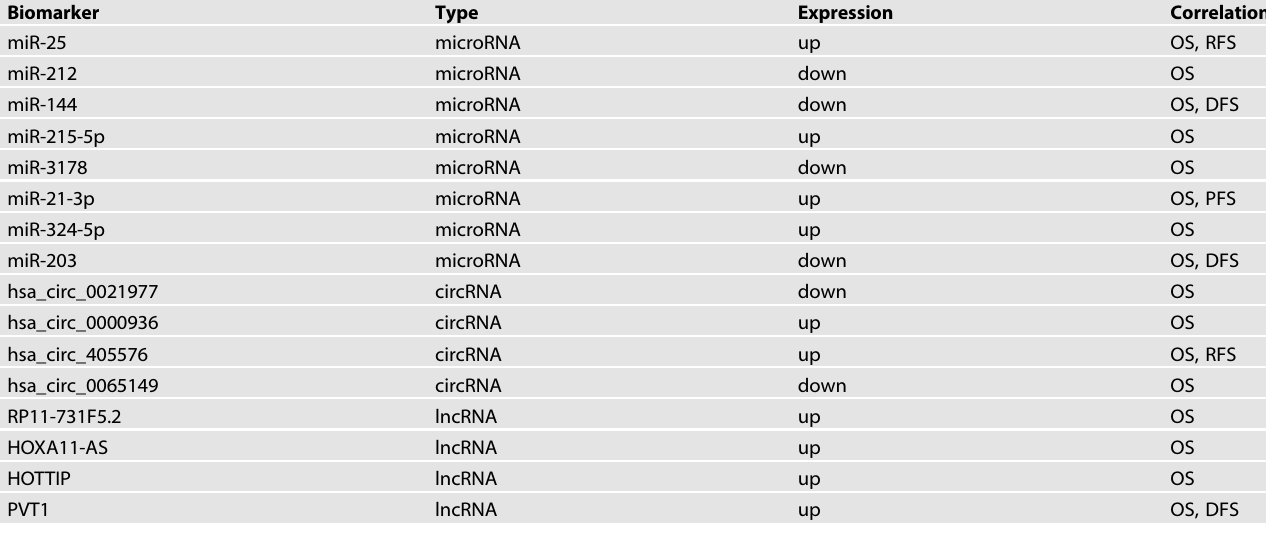
Table 3. Exosomal RNAs in prognostic evaluation of GC.